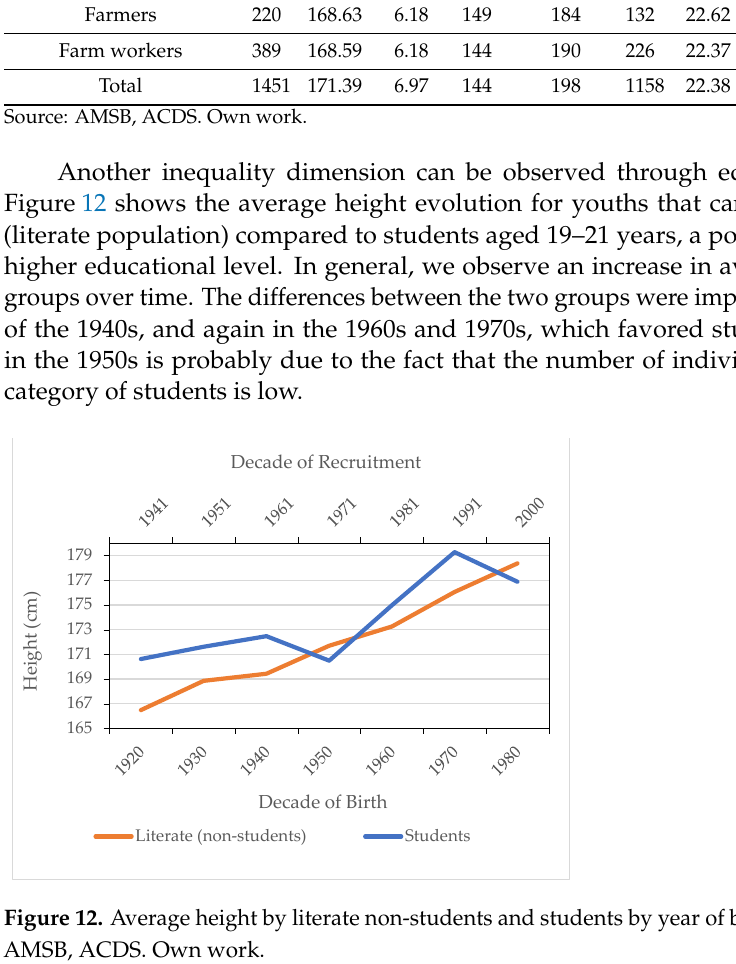
Figure 12. Average height by literate non-students and students by year of birth/recruitment. Source: AMSB, ACDS. Own work.